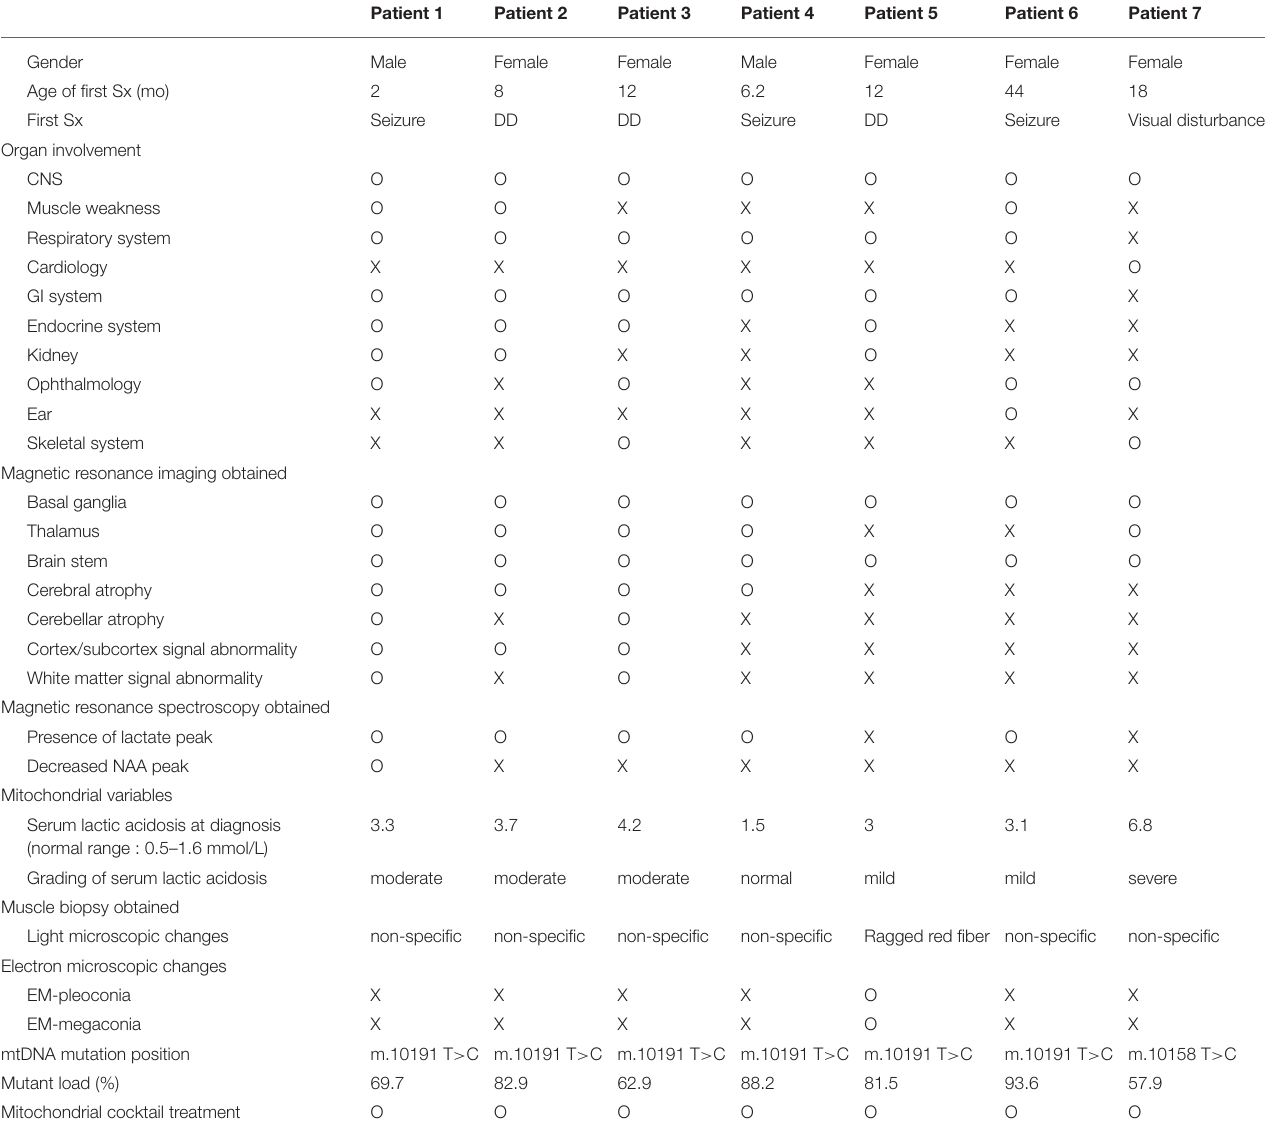
TABLE 1 | General characteristics of Leigh syndrome with MT-ND3 mutation (Total N =